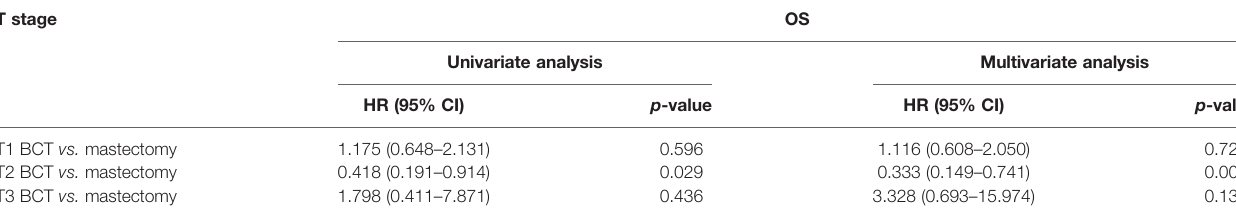
TABLE 4 | Univariate and multivariate regression analysis strati fi ed according to T